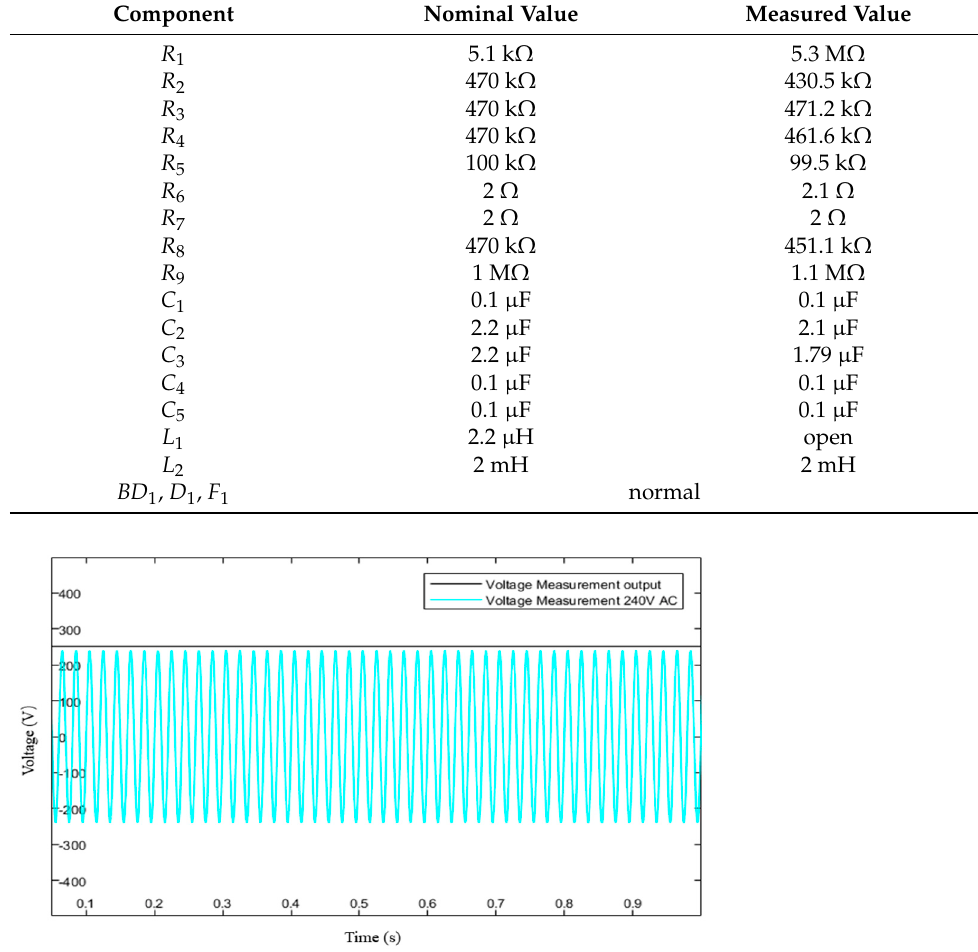
Figure 12. Simulated waveforms of the output of rectifier and filter circuit under 240 V AC for nominal L 1 and R 1 values (Sample A).